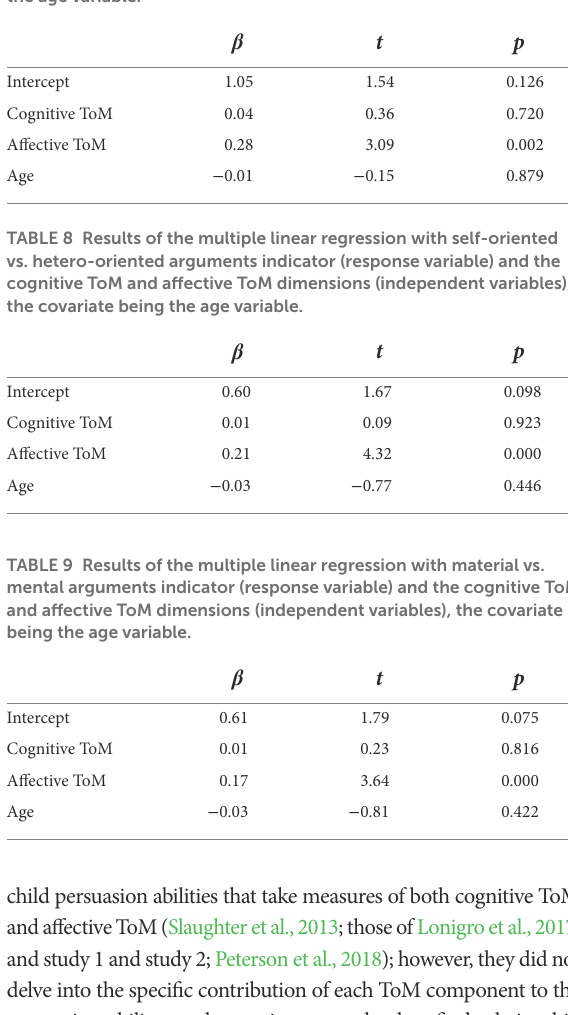
TABLE 7 Results of the multiple linear regression with quality of the arguments total score (response variable) and the cognitive ToM and affective ToM dimensions (independent variables), the covariate being the age variable.